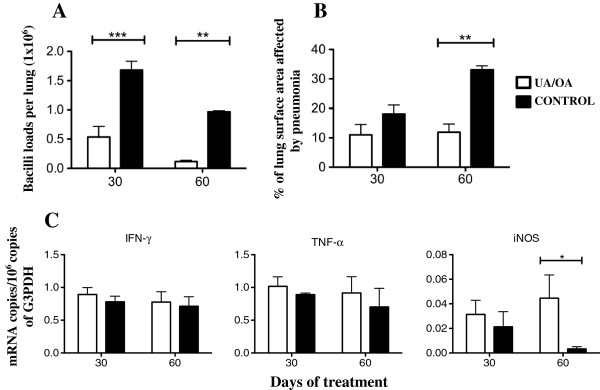
Effect of Ursolic acid (UA)/Oleanolic acid (OA) administration on bacterial loads, pathology and cytokine expression during advanced disease in lungs from mice infected with the M. tuberculosis H37Rv strain. (A) UA/OA administration (white bars) starting 60 days after infection decreased pulmonary bacterial loads when compared with those of control mice (black bars). (B) UA/OA-treated mice (white bars) at days 30 and 60 post-treatment showed less pneumonic area than the control group. (C) UA/OA treatment induced a slightly higher expression of TNF-α and IFN-γ, and a significantly higher expression of inducible iNOS at day 60 when compared with non-treated control mice. ABS: correspond to 10 μg kg-1 rifampicin, 10 μg kg-1 isoniazid and 30 μg kg-1 pyrazinamid. Each point corresponds to the mean ± Standard deviation (SD) of groups of four mice. Asterisks represent the statistical significance between groups (*P <0 · 05; **P <0 · 01).